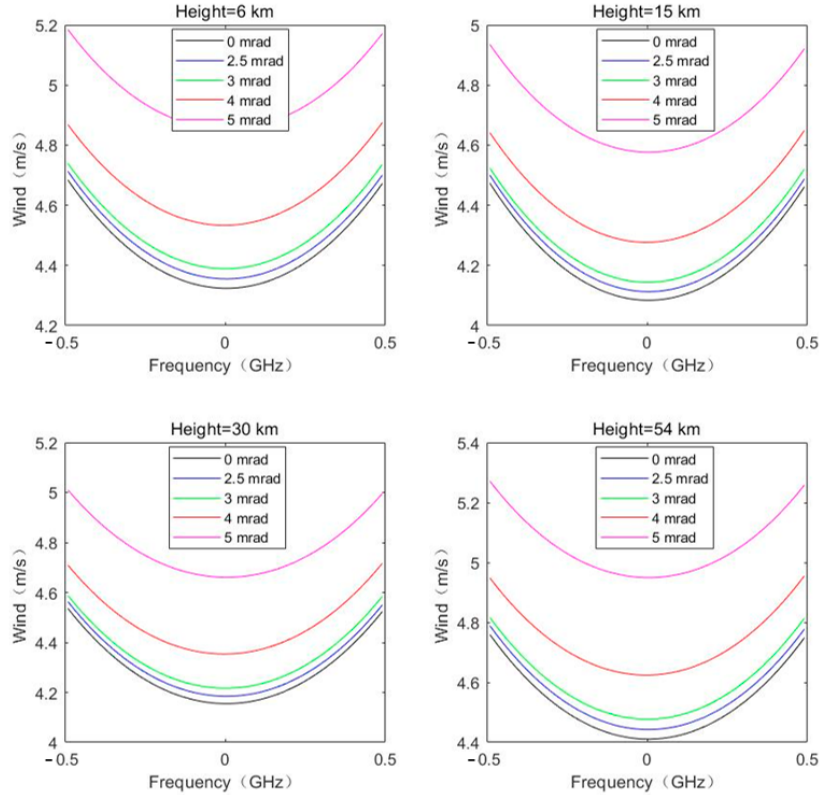
Figure 4. Effect of different incident light divergence angles on radial wind speed errors at different heights.